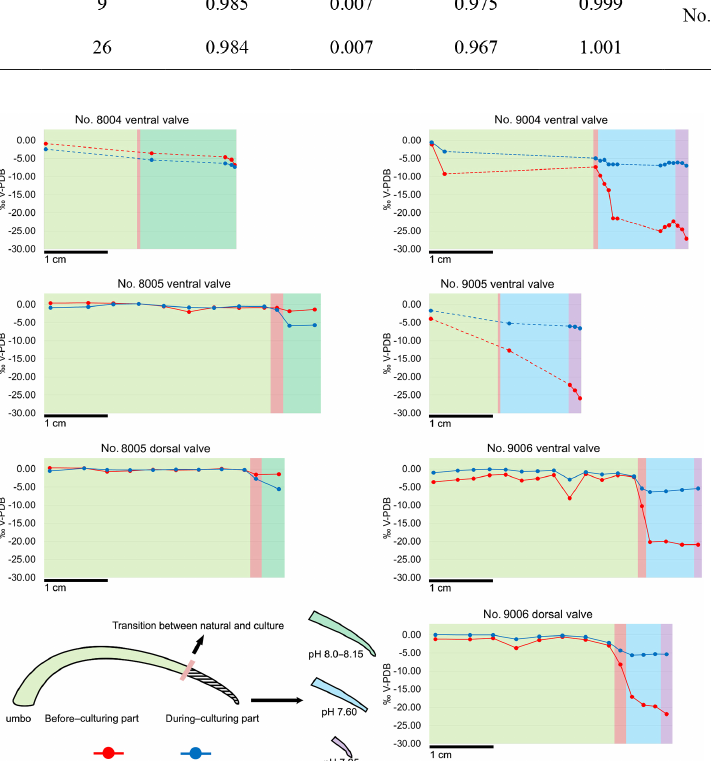
Figure 10. Plots of δ 13 C and δ 18 O of the ventral and dorsal valves of M. venosa specimens along their growth axis. Different colour backgrounds represent different pH conditions during growth. When few data were available, data points were joined by dashed